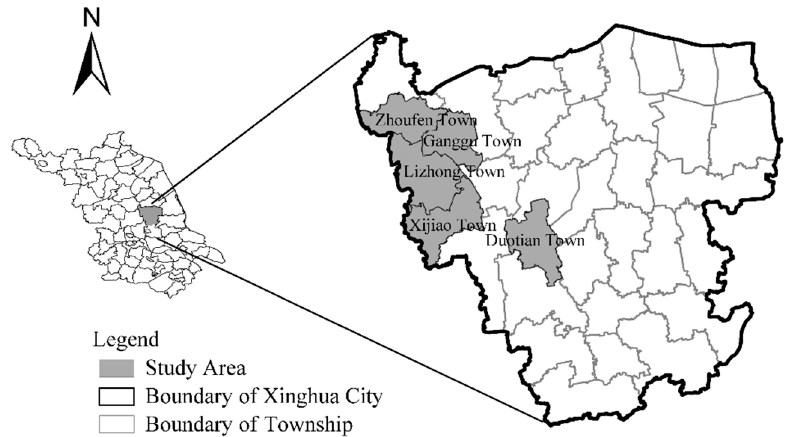
Figure 2. Location and range of Xinghua Duotian Agrosystem.